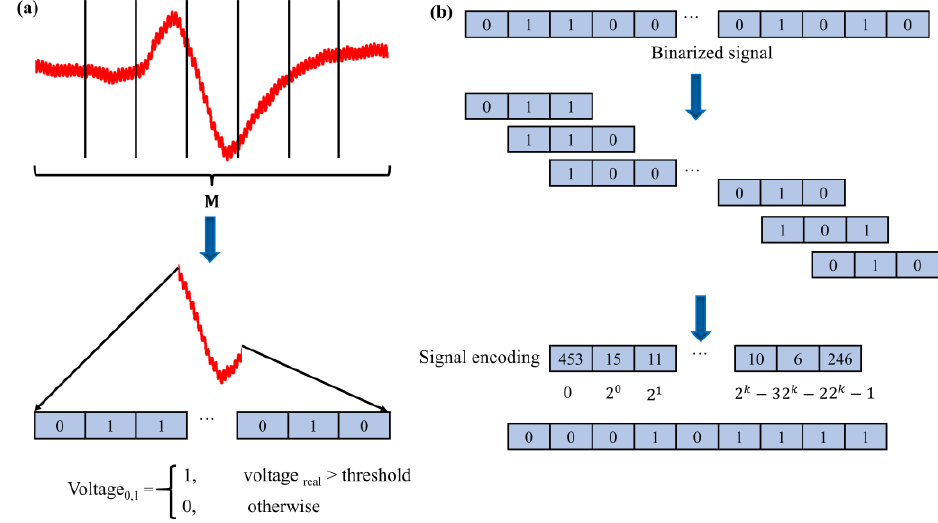
Figure 3. Schematic diagram of K-mer-based signal encoding process. ( a ) Signal binarization. ( b ) K- mer signal encoding.